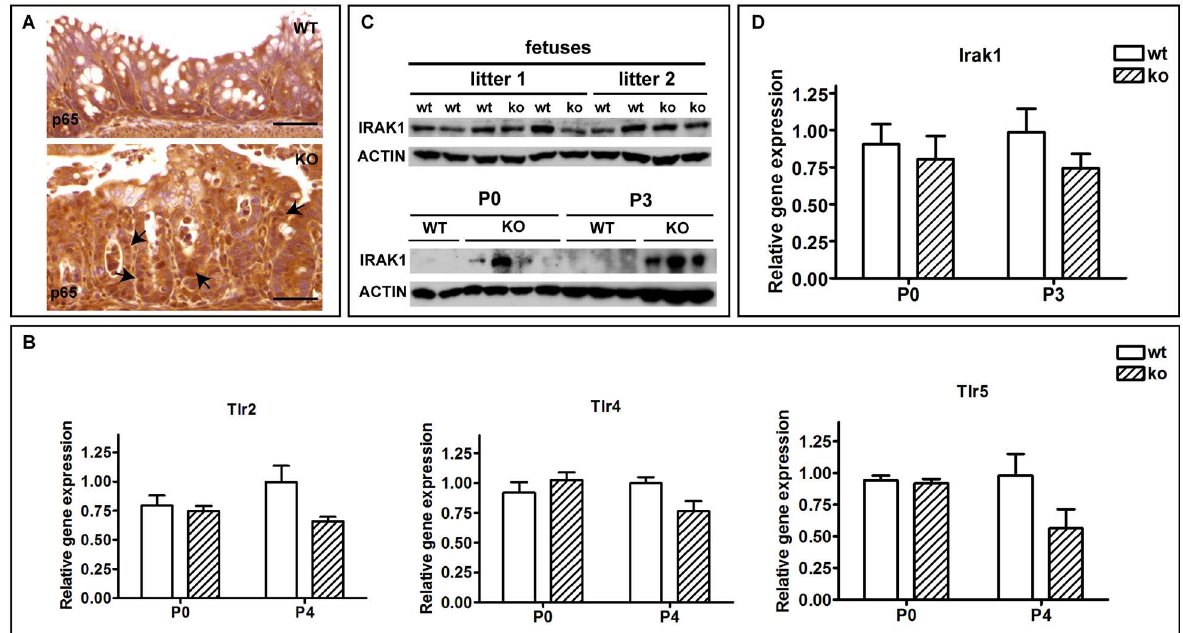
Fig 7. The IEC-specific hnRNPI knockout neonates display hyperactive NF- κ Bsignaling and upregulation of IRAK1 protein expression in the colon. (A) Immunohistochemicalstaining with an anti-p65antibody shows p65 nucleartranslocation in the colonic epithelium of the knockout mice at P3 (the bottom panel,arrows). (B) Real-timePCR results show that the expressionof TLRs is not increasedin the colon of the knockout mice at both P0 and P4. (C) Western blot shows IRAK1 protein expressionis increasedin the knockout colon at P0, and the increase of IRAK1 protein level is more prominentat P3. The IRAK1 protein level remainsunchangedin the knockout fetal colon. Actin is served as the loadingcontrol. At least 3 litters of each age were tested and data shown are representative. (D) Real-timePCR result shows that the mRNA level of IRAK1 in colons of the knockout neonatesis not upregulatedat both P0 and P3. Data in B and D are presented as mean values relative to Gapdh ( ± s.e.m). N = 3–5 mice per group. The knockout group and the wild-type group are siblinglittermates. At least 3 litters of each age were tested and data shown are representative. WT, wild-type;KO, knockout. Scale bars, 50 μ